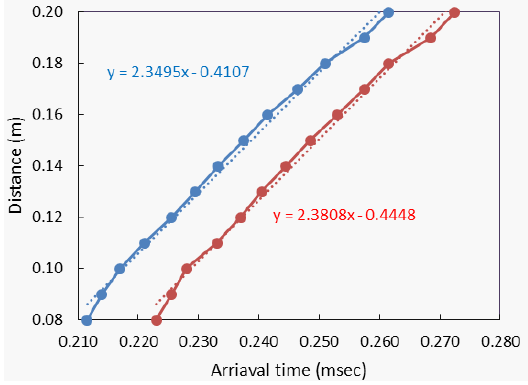
Figure 16. Presentation of surface wave arrival times derived from data shown Figure 15; contact accelerometers shown with blue and with contactless MEMS with red. The slope of the fit lines indicates surface wave group